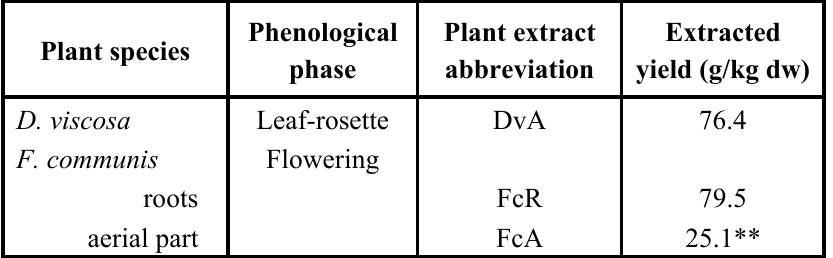
Table 1. Plant species, phenological phase, plant extract abbreviation and extracted yields from plant material (mean values followed by ** are significantly different at P < 0.01 according to Duncan’s multiple range